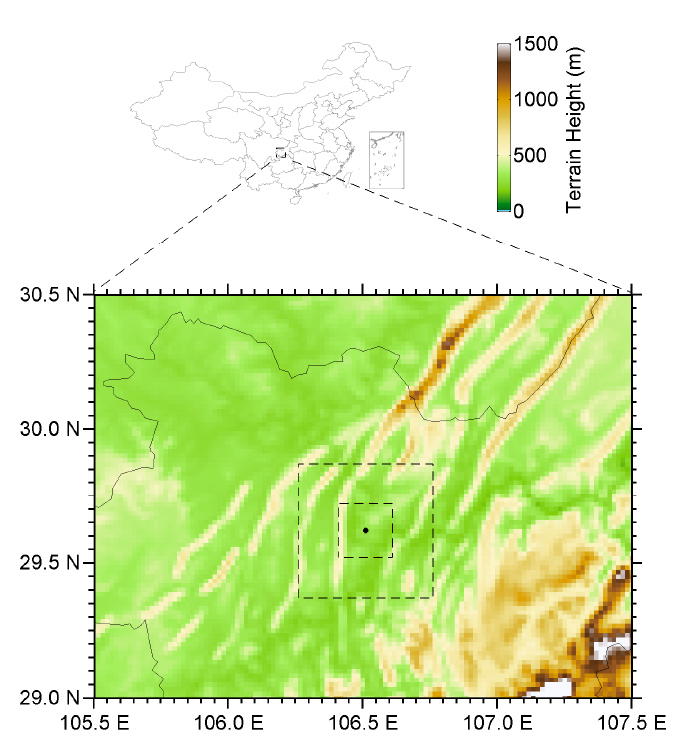
Figure 1. The location of the ground site (black dot) and topography of surrounding areas (pseudo-color background). The inner and outer dashed boxes are 20 km by 20 km and 50 km by 50 km boundaries for satellite-ground collocation.